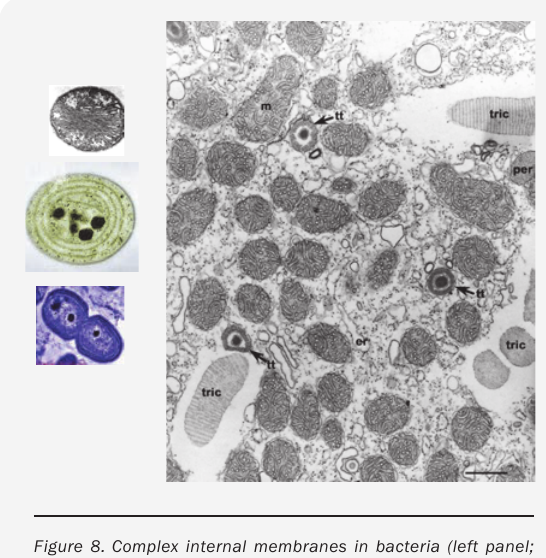
Angert.Figure 8. Complex internal membranes in bacteria (left panel; nitrosococcus, cyanobacteria and nitrosomonas) compared with mitochondria in a section of the single-celled eukaryote Parame- cium (courtesy of R. Allen). Roughly to scale. Eukaryotes do not only have internal membranes, they also have pared-down bioenergetic genomes, the mitochondrial genome. They therefore display a topo- logical restructuring in which bioenergetic membranes are invariably associated with small bioenergetic genomes that seem to be neces- sary for their